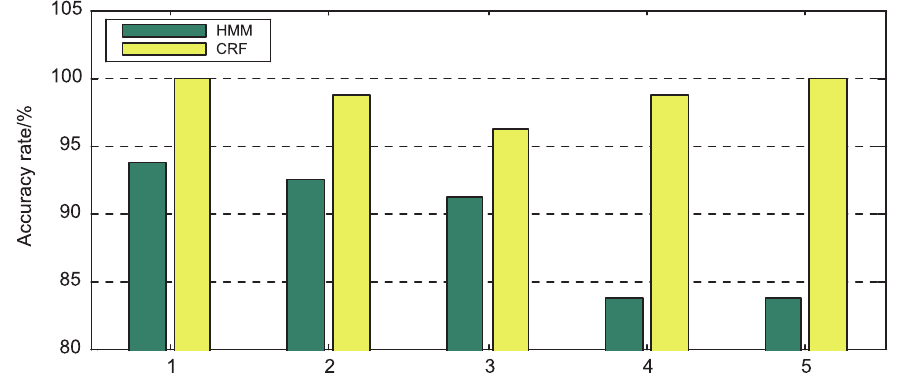
Fig. 7. Comparison of CRF with HMM under five-fold cross validation.